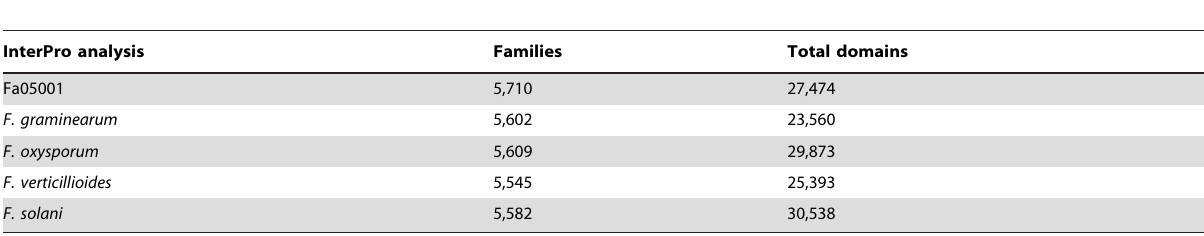
Table 2. InterproScan analysis and comparison of Fa05001 with other